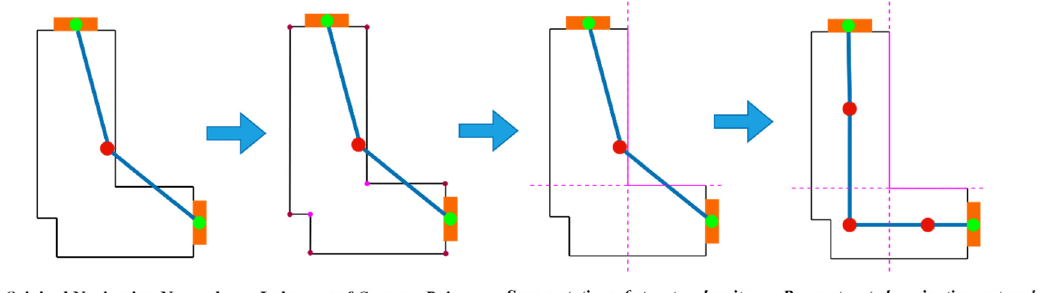
Figure 10. Corridor navigation network generation and adjustment. The purple dots are corridor nodes. The red dots and green dots are abstract nodes. The thick blue lines indicate the connection relationship between nodes. ( a ) represents the initial navigation network. ( b ) represents the corridor node optimized navigation network.